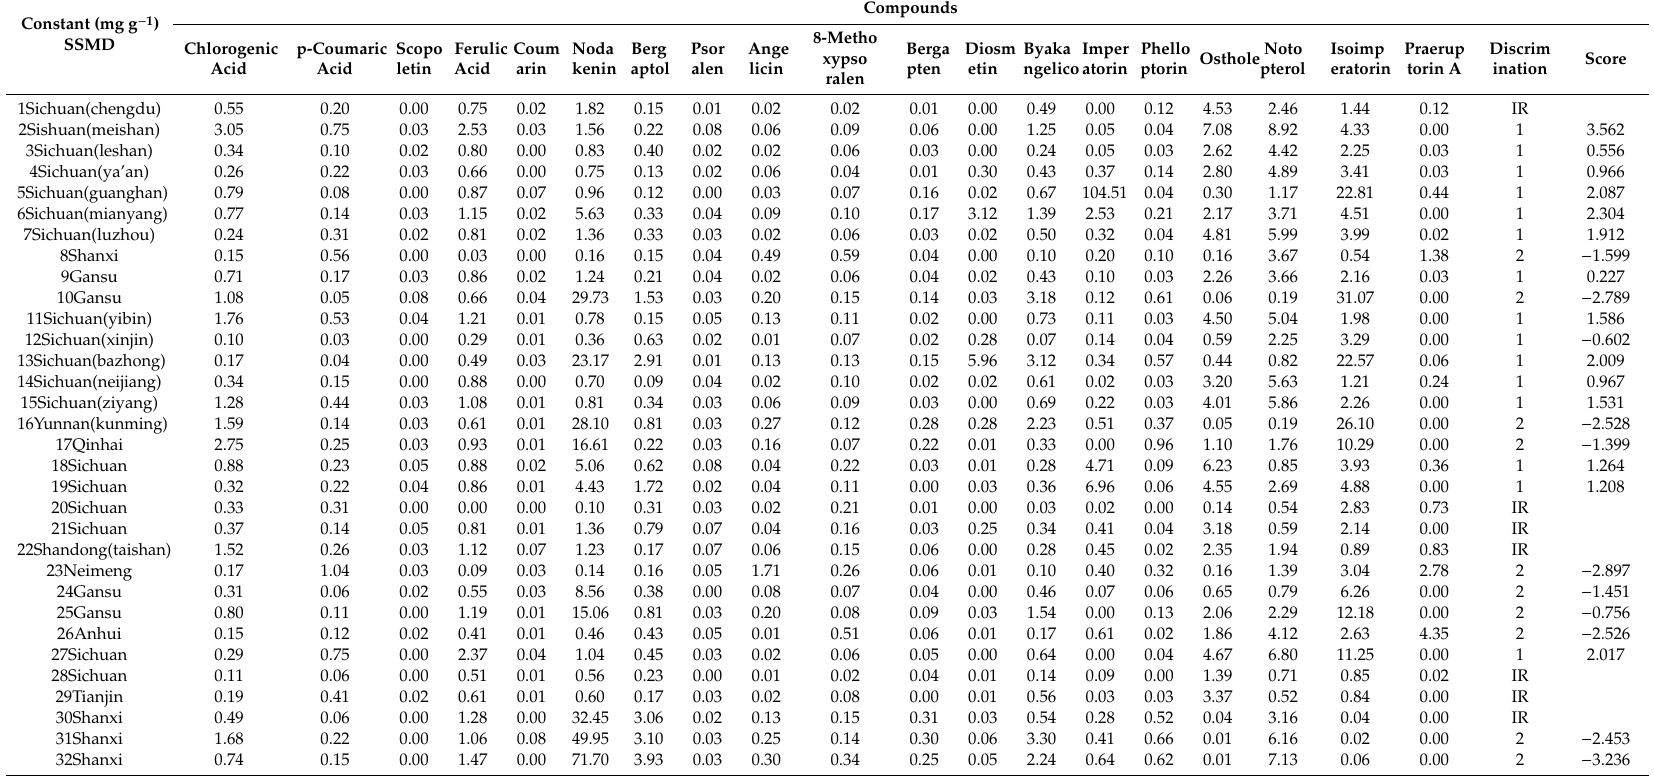
Table 6. Contents of 19 compounds in di ff erent samples using the SSMD method and the result of discriminant